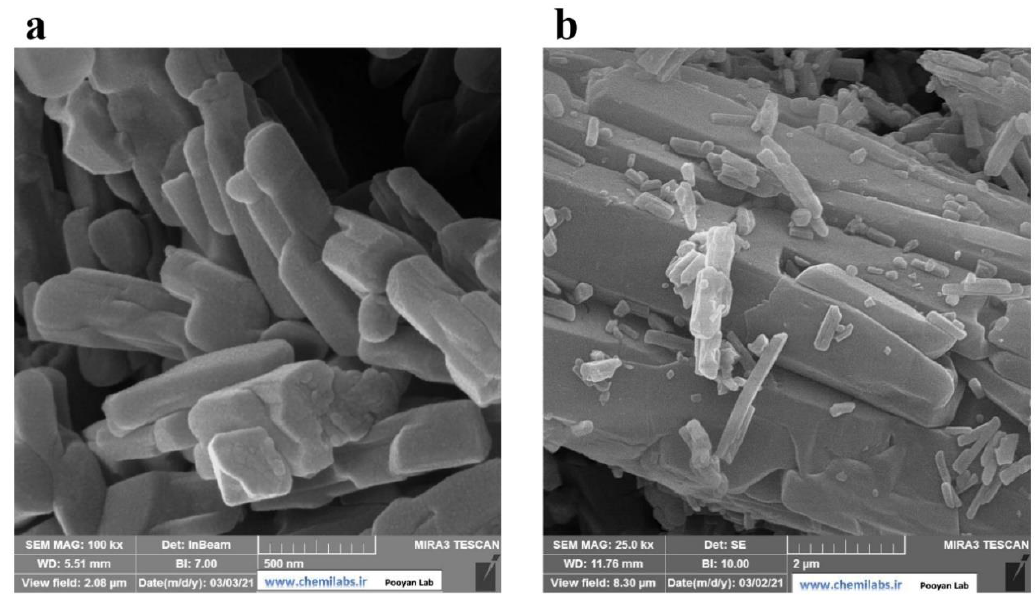
Figure 3. FE-SEM images of the CoMOF in ( a ) 500 nm and ( b ) 2 µM.